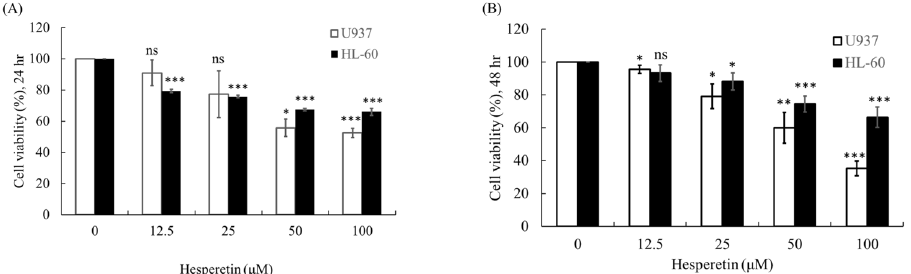
Figure 1. Effect of hesperetin on human leukemic cell viability. HL-60 and U937 cell lines (4 × 10 4 cells/mL) were treated with hesperetin at 0, 12.5, 25, 50, and 100 µM for 24 h ( A ) and 48 h ( B ). Cell viability was evaluated using a CCK-8 assay. The Y -axis indicates the percentage of cell survival, and the X -axis indicates various concentrations of hesperetin. The mean ± SD of the three independent experiments performed in triplicate are shown. * p < 0.05; ** p < 0.01; *** p < 0.001 vs. the control group; ns, not significant; the results are representative of three independent experiments.